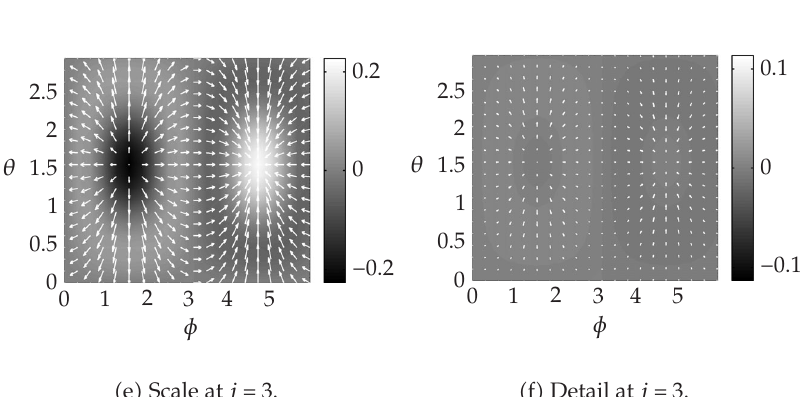
( f ) Detail at j = 3.